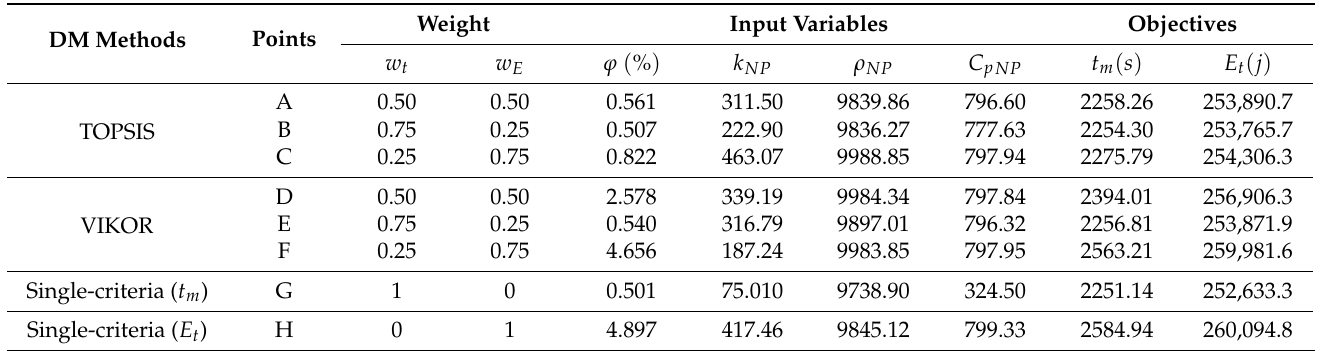
Table 6. Comparison of the selected optimal